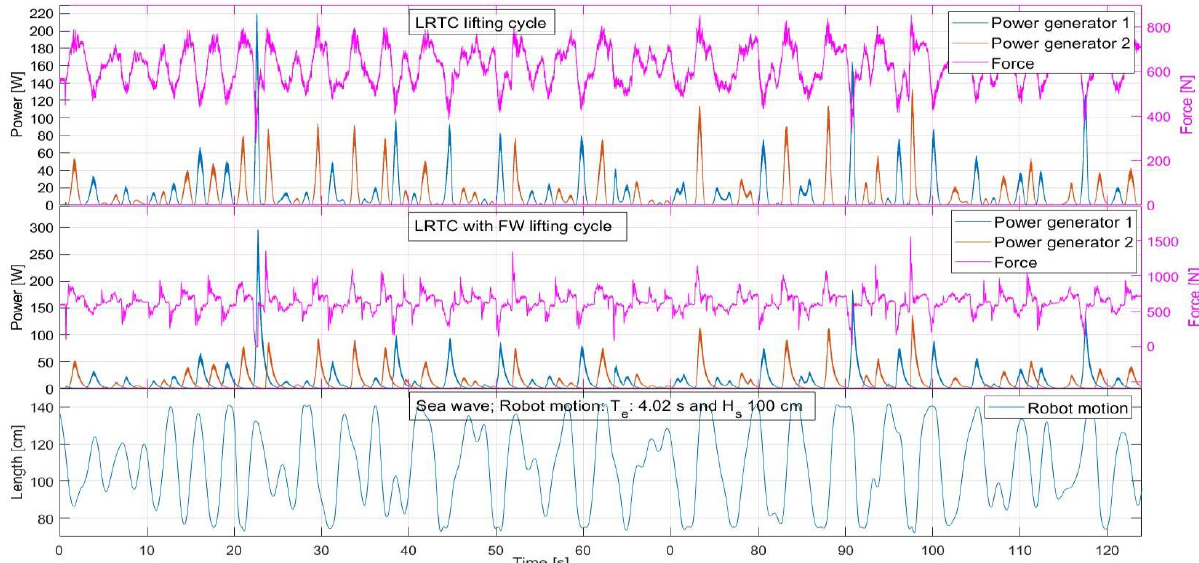
Fig. 13. The LRTC lifting cycle series for Exp. II.3a and 3b. Sea wave motion with Hs = 1.0 m and Te = 4.02 s